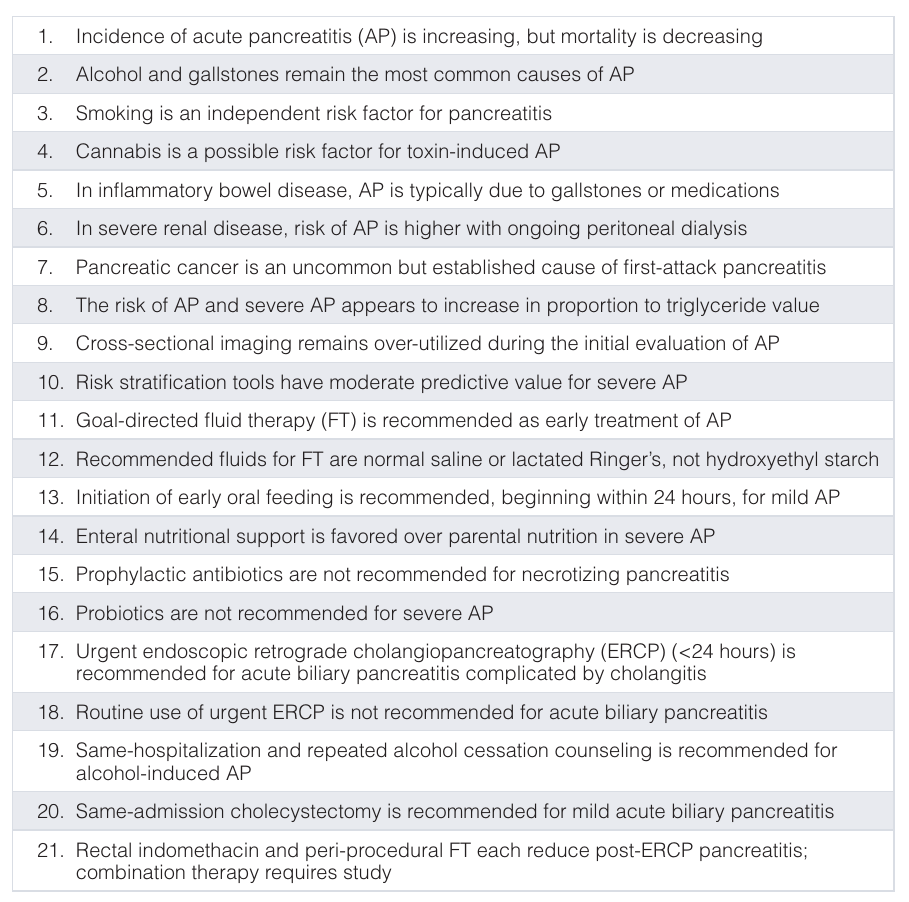
Table 1. Recent advances in epidemiology, evaluation, and management of acute